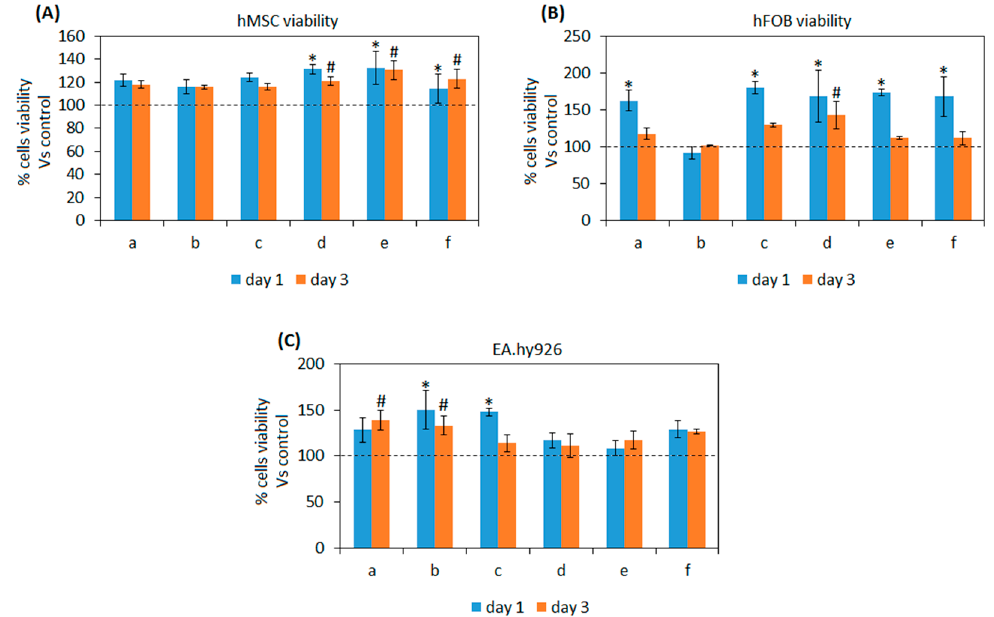
Figure 4. Composites’ cytocompatibility towards mesenchymal stem cells ( A ), osteoblasts progenitors ( B ), and endothelial cells ( C ). All the composites formulations reported viability values >100% (indicated by the dashed lines) in comparison with 100% BG controls. Moreover, significant differences were noticed after 1 day ( p < 0.05, indicated by the *) or 3 days ( p < 0.05, indicated by the #) between composites as control. Bars represent means and standard deviations. a: BG-Cn-GPTMS10, b: BG-Cn-GPTMS20, c: BG-Gel-GPTMS10, d: BG-Gel-GPTMS20, e: BG-Cn-Gel-GPTMS10, f: BG-Cn-Gel-GPTMS20. Experiments were performed using six replicates for each specimen.